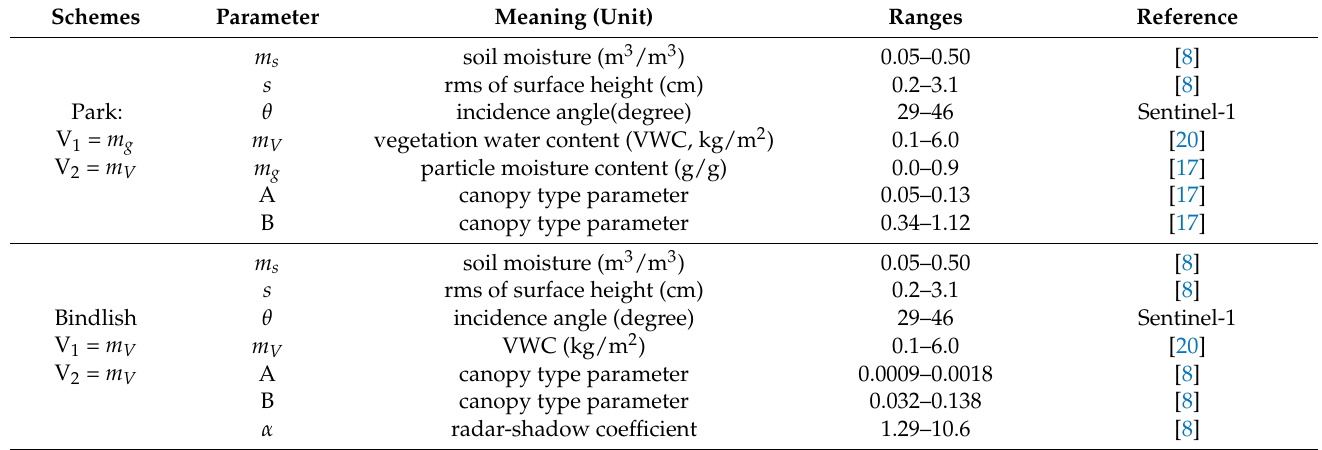
Table 1. Parameters in the coupled Oh–WCM model and their ranges for